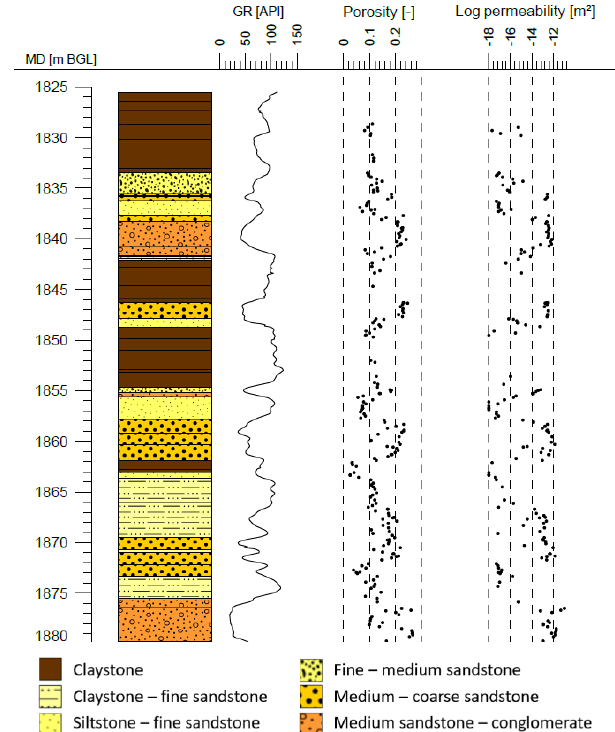
Figure 5. Exemplary lithology profile, gamma-ray log (both cour- tesy of Exxon Mobil), porosity and permeability data (from the Ge- ological Survey of Lower Saxony; Bär et al., 2013; Bär and Sass, 2015) of one of the analysed